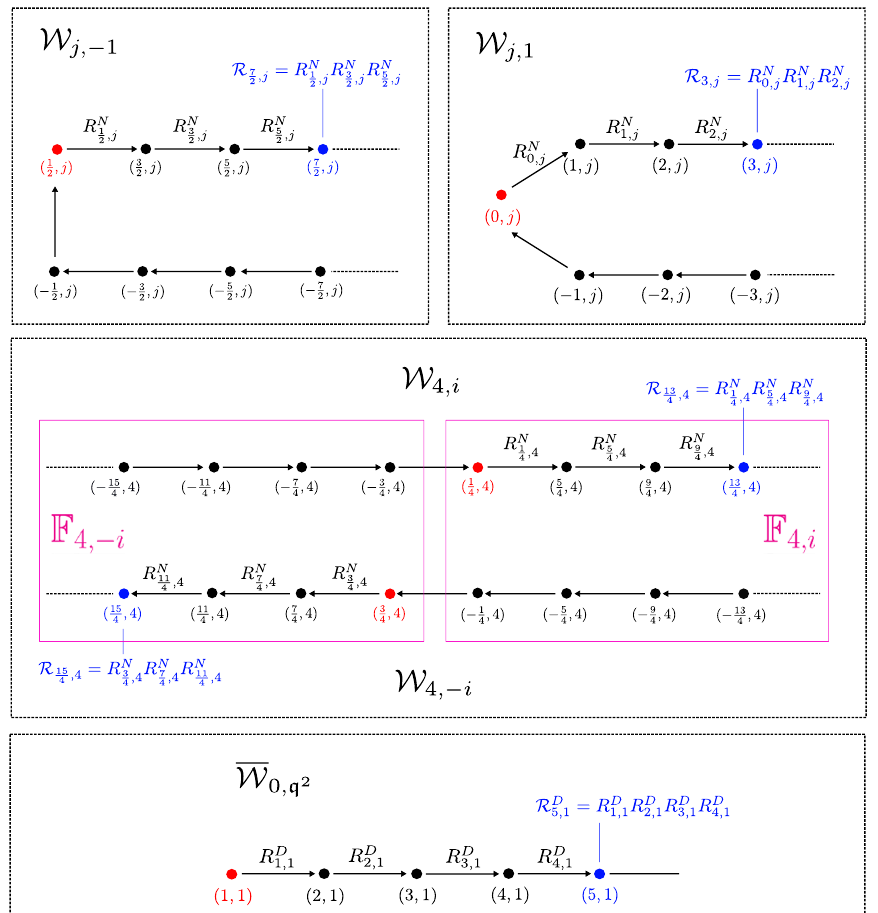
Figure 2 . Examples of the construction of interchiral conformal blocks F (cid:0) (cid:1) N indicate the fields ( r, s ) = e + p , j , ( e + 1 , 1) D whose amplitudes satisfy the recursion R D,N M in eqs. (4.14) and (4.5) under e → e + 1 as illustrated by the arrows. The leading primary in each ATL module whose amplitude is taken as A ( W ) in (4.3) and (4.13) is labeled red. We give explicit examples of the coefficients R for sub-leading fields entering the blocks indicated with